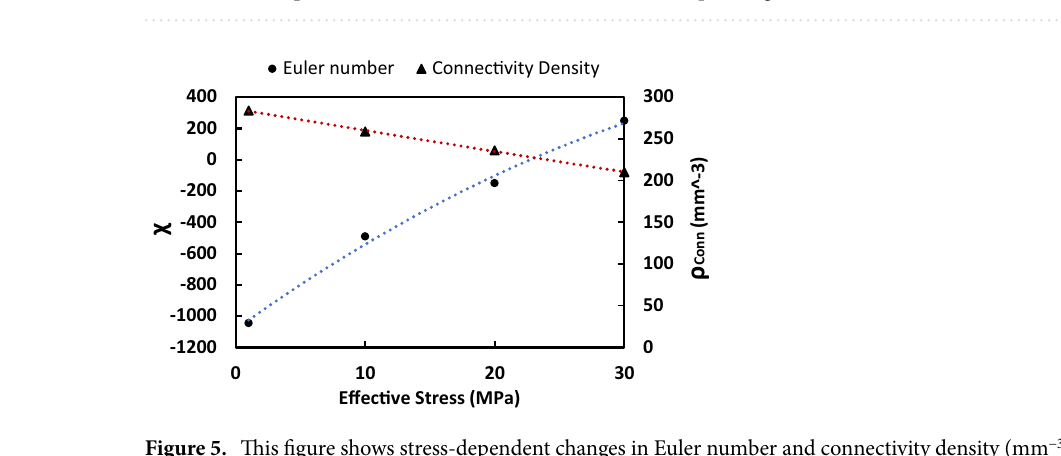
Figure 4. Pore-scale modeling results representing stress-dependent SI and multiphase flow properties of the cubic specimen using σPFM technique. This figure provides insights into stress-dependent ( a ) relative permeability k r , ( b ) capillary pressure P c , ( c ) fitting constants n and β in Eqs. (6–8), ( d ) curve fitting endpoints k rwm and P e in Eqs. (6–8), and ( e ) N w over time with the corresponding C values for the cube.